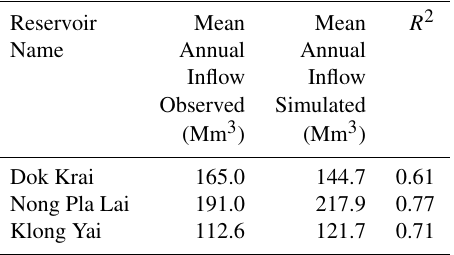
Table 2. Calibration results of SWAT model for reservoirs over Klong Yai River